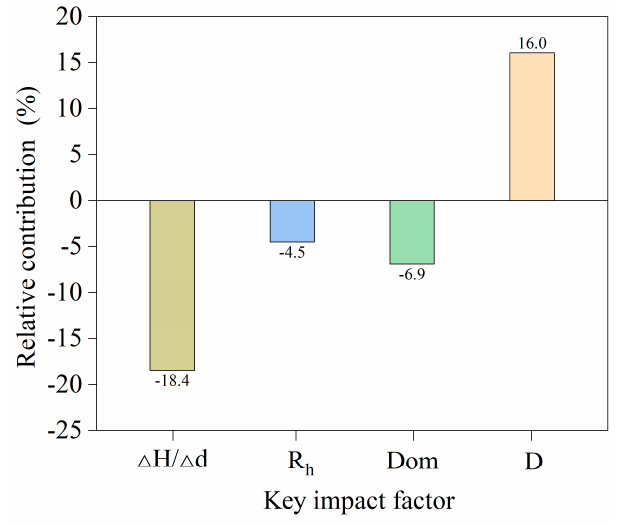
Figure 9. Relative contribution rate of R h , Dom and D to the daily solar radiation income of individual trees ( R i ) compared to a reference R i . The reference R i was modeled by Equation (10) with the long-term means of R h , the Δ H / Δ d value of 0 (Figure 5c) and the mean Dom and D of the 835 sample trees on the hillslope. ( Δ H / Δ d represents the ratio of the height difference to the horizontal distance between the sample point and the top of the opposite mountain (i.e., the variation of slope position); R h represents the daily solar radiation income of the horizontal ground; Dom represents the social position levels of sample trees; D represents the mean distance between trees and neighboring trees). The response of R i to D exhibited the same trend at different slope positions and different Dom levels, and an obviously higher rate of increase occurred under higher Dom levels (Figure 10). For example, given the ∆ H / ∆ d value of 0.1 and Dom value of 0.3, the effect of D on R i only gradually decreased when D was greater than 6.0 m, while given the ∆ H / ∆ d value of 0.1 and Dom value of − 0.3, R i stabilized when D was greater than 3.0 m.